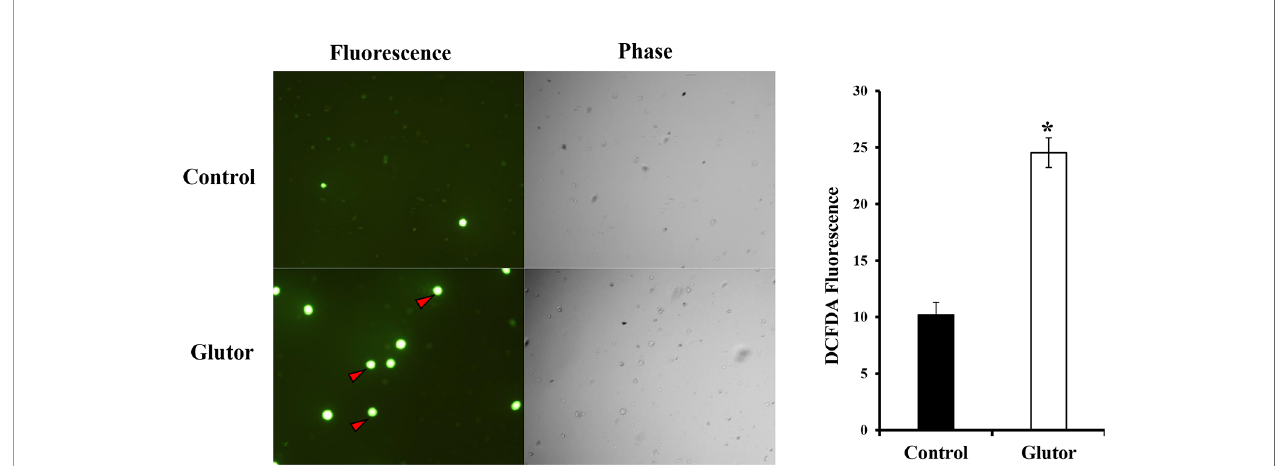
FIGURE 5 | Glutor treatment elevates intracellular ROS expression in DL cells. DL cells (1 × 10 5 ) were incubated for 2 h in a medium with or without glutor (0.01 µM), followed by staining with DCFDA and examination of the cells in fl uorescence optics as described in the Materials and Methods section. The plates shown are from a representative experiment out of at least two experiments with similar results. The accompanying bar diagram depicts the fl uorescence intensity of control and glutor-treated cells. Values are mean ± SD. * p < 0.05 vs. control.